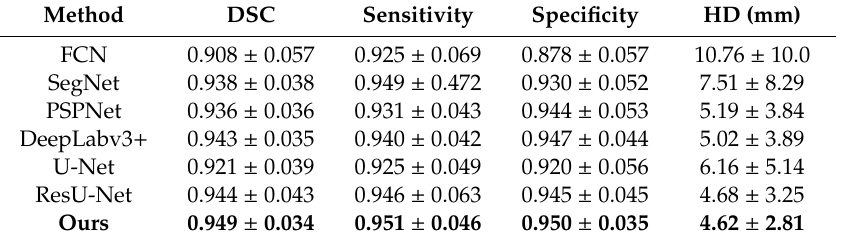
Table 1. The performance of various models on the MF test set (the best results are indicated in bold).